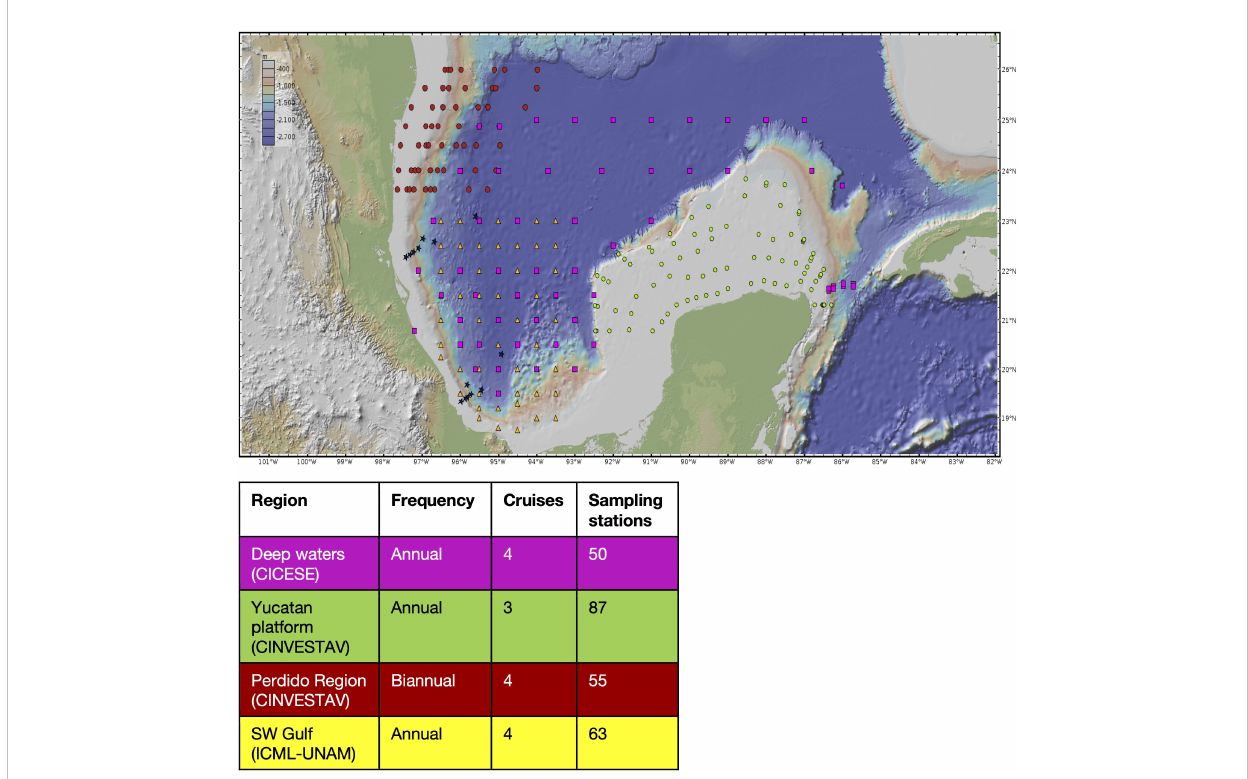
FIGURE 2 Map of the cruises accomplished by CIGOM in the Gulf of Me ́ xico. Station visited during XIXIMI cruises in the deep water region of the GoM ( fi lled purple squares); location of the stations visited during CINVESTAV-Me ́ rida cruises on the Yucata ́ n Platform ( fi lled light green circles); location of the stations visited during the CINVESTAV-Me ́ rida cruises in the Perdido region ( fi lled red circles); location of the stations visited during ICML-UNAM cruises in the southern GoM ( fi lled yellow